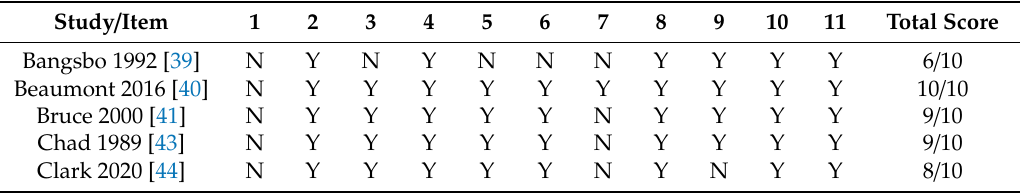
Table 1. Scores for the Physiotherapy Evidence Database (PEDro)